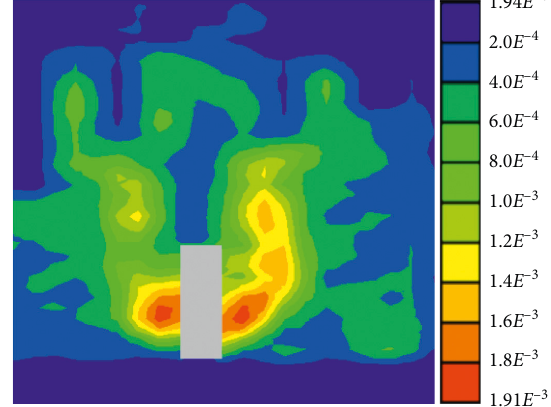
Figure 9: Cloud of the maximum shear strain increment.